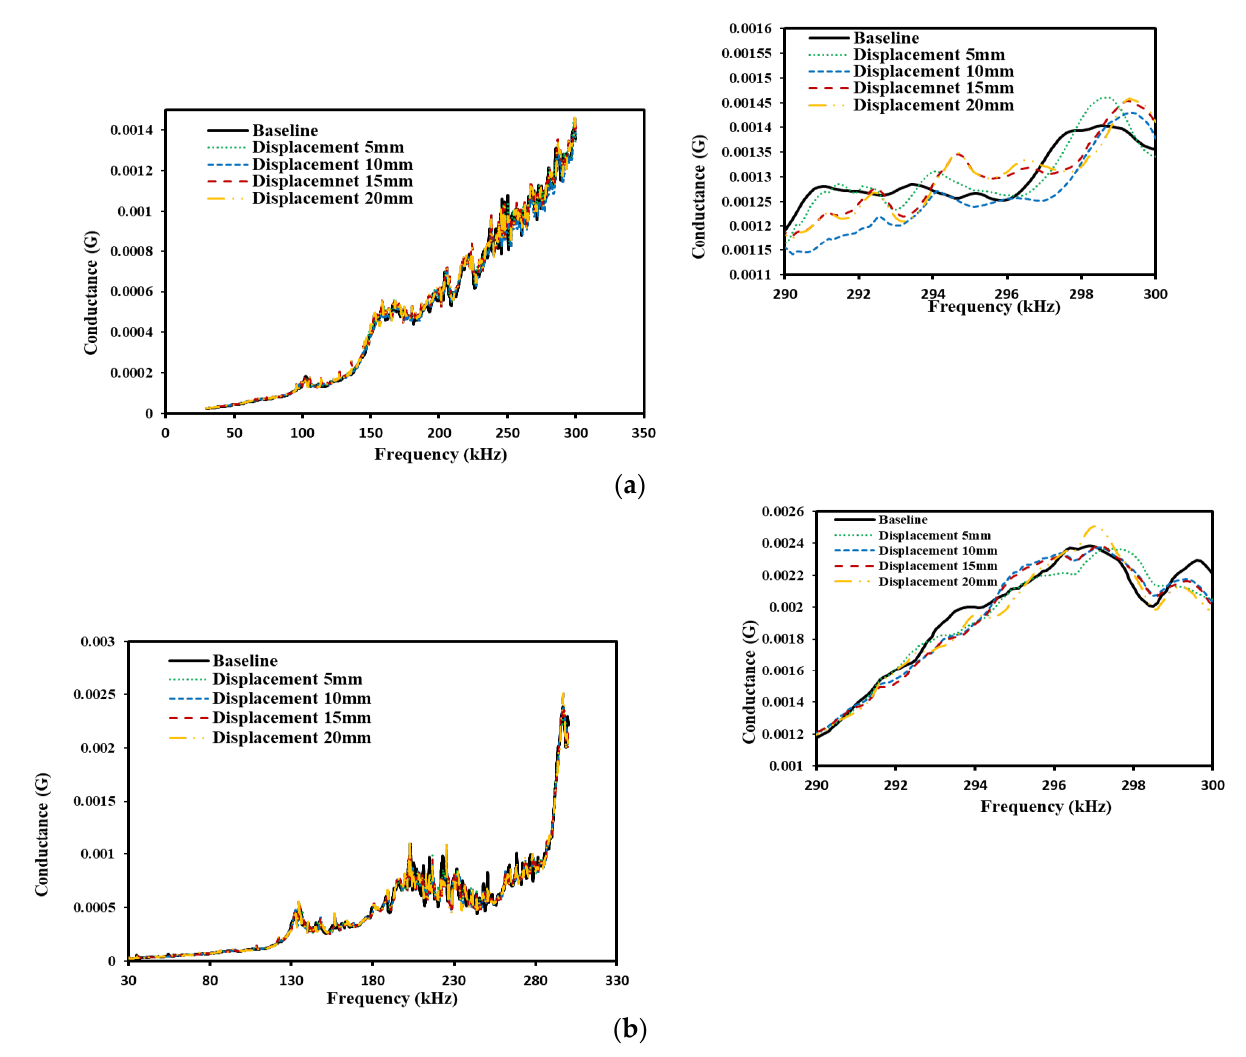
Figure 10. Variation of conductance signature at different displacement level, ( a ) Sample 1, ( b ) Sample 2.